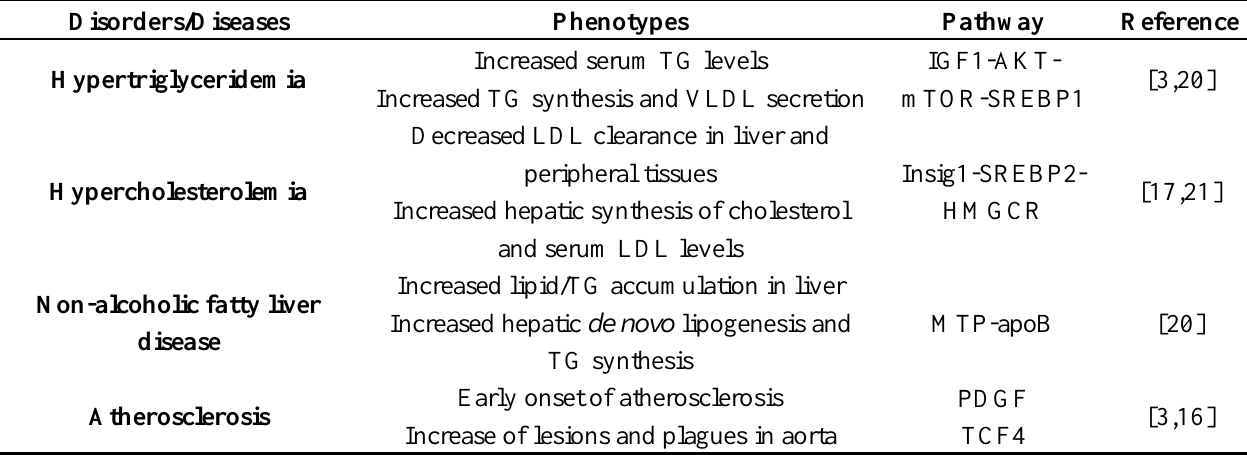
Table 1. Summary of the disorders/diseases caused by malfunction of